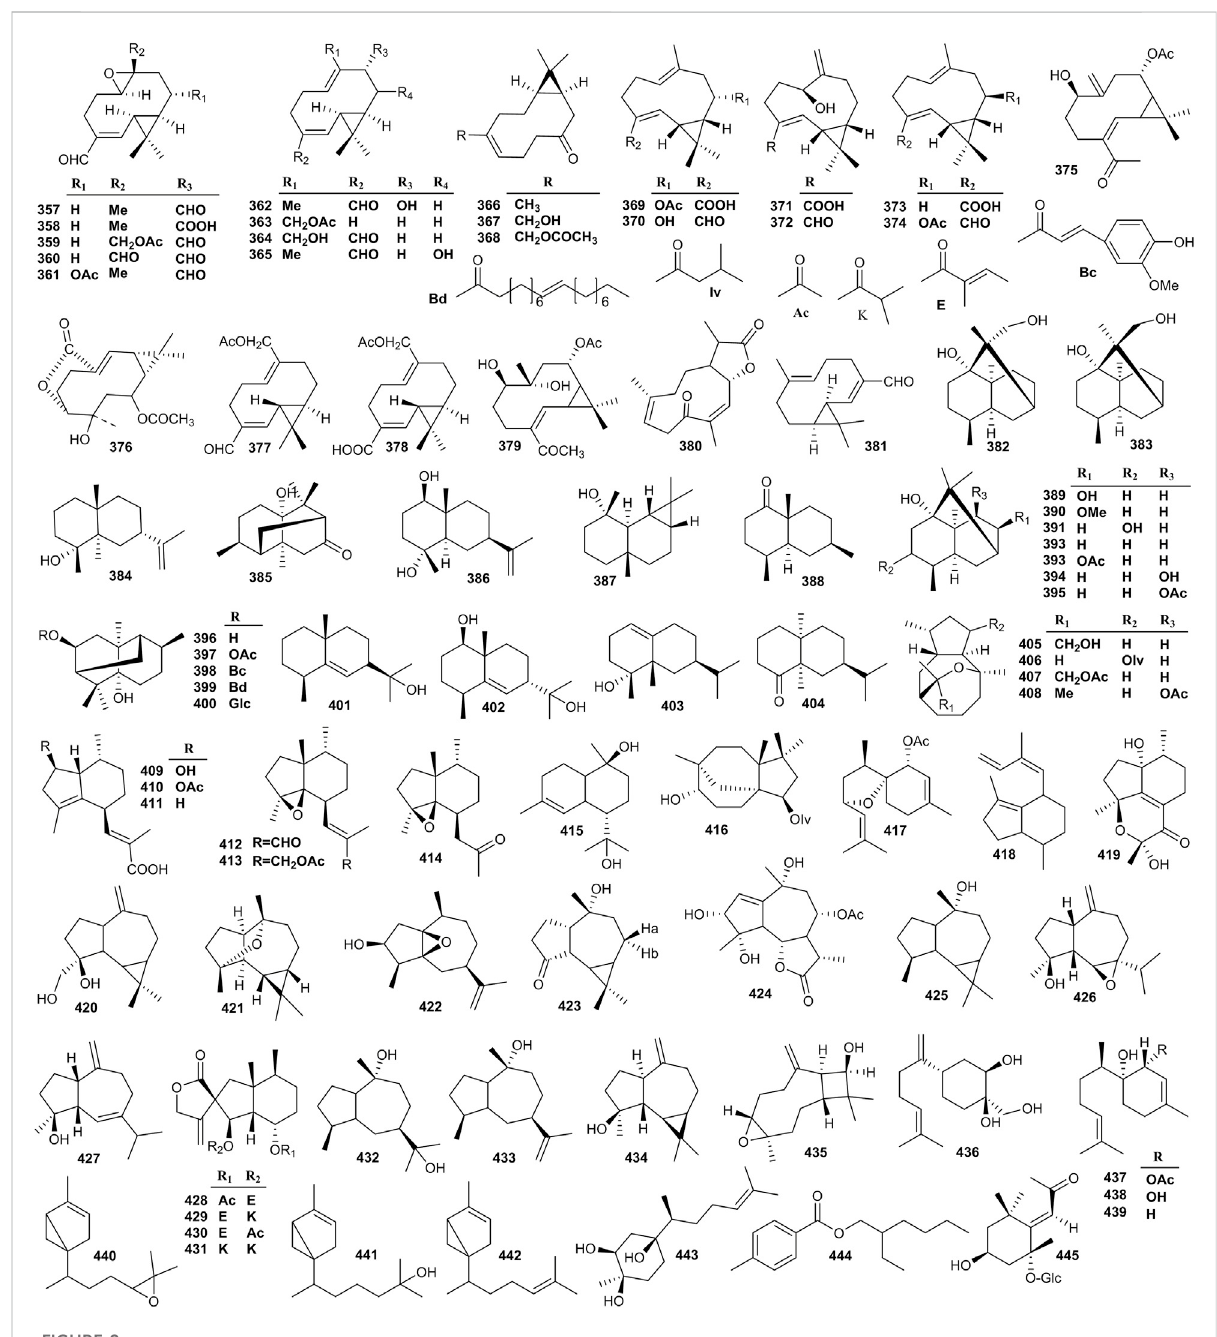
FIGURE 8 Structures of sesquiterpenoids from the genus Valeriana